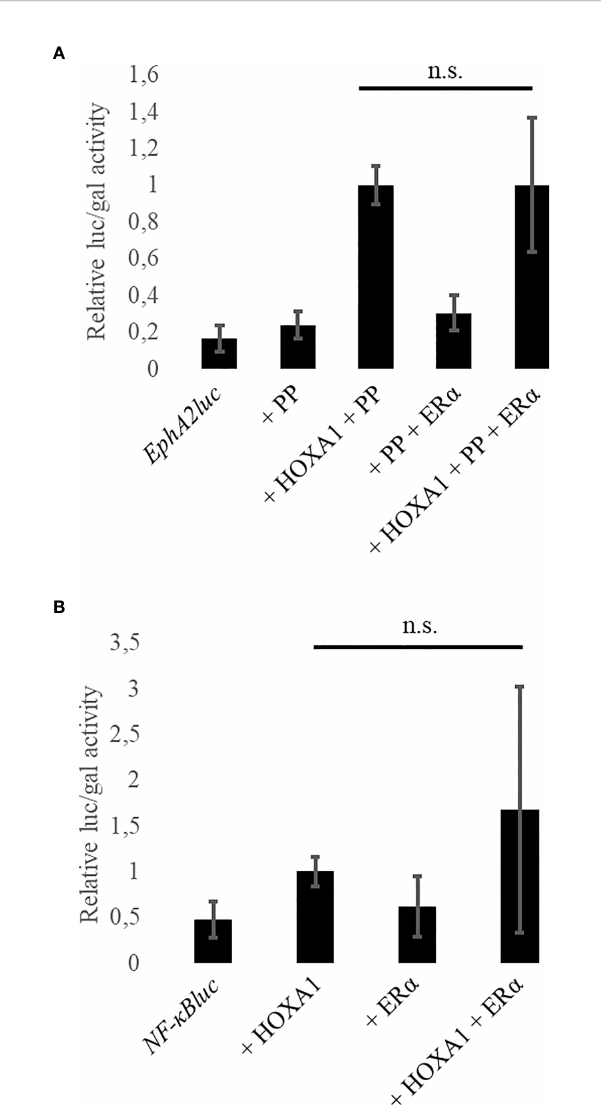
FIGURE 9 | ER a does not interfere with transcriptional and non-transcriptional HOXA1 activities. (A) MCF10A cells were transfected with plasmids encoding Flag-HOXA1, PREP1, PBX1A, ER a along with CMV::lacZ and EphA2luc . Reporter luciferase activity (luc) was reported to the b -galactosidase activity (gal). HOXA1 activates EphA2luc in the presence of the cofactors PREP1 and PBX1A (set to 1). The HOXA1-mediated activation is not in fl uenced by the presence of ER a (N=11, n ≥ 2). PP stands for PREP1 and PBX1A. The activation of EphA2luc in presence of HOXA1 and PREP1 and PBX1A was set to 1. n.s. : non-signi fi cant. (B) MCF10A cells were transfected with plasmids encoding Flag-HOXA1, PREP1, PBX1A, ER a along with CMV::lacZ and the NF- k B reporter ( NF- k Bluc ). NF- k B-mediated luciferase activity (luc) was reported to the b -galactosidase activity (gal). HOXA1 activates the NF- k B reporter (set to 1) and this activation is not in fl uenced by the presence of ER a (N=14, n ≥ 2). n.s., non-signi fi cant. Error bars represent standard deviation for N experiments and n replicates per experiment.